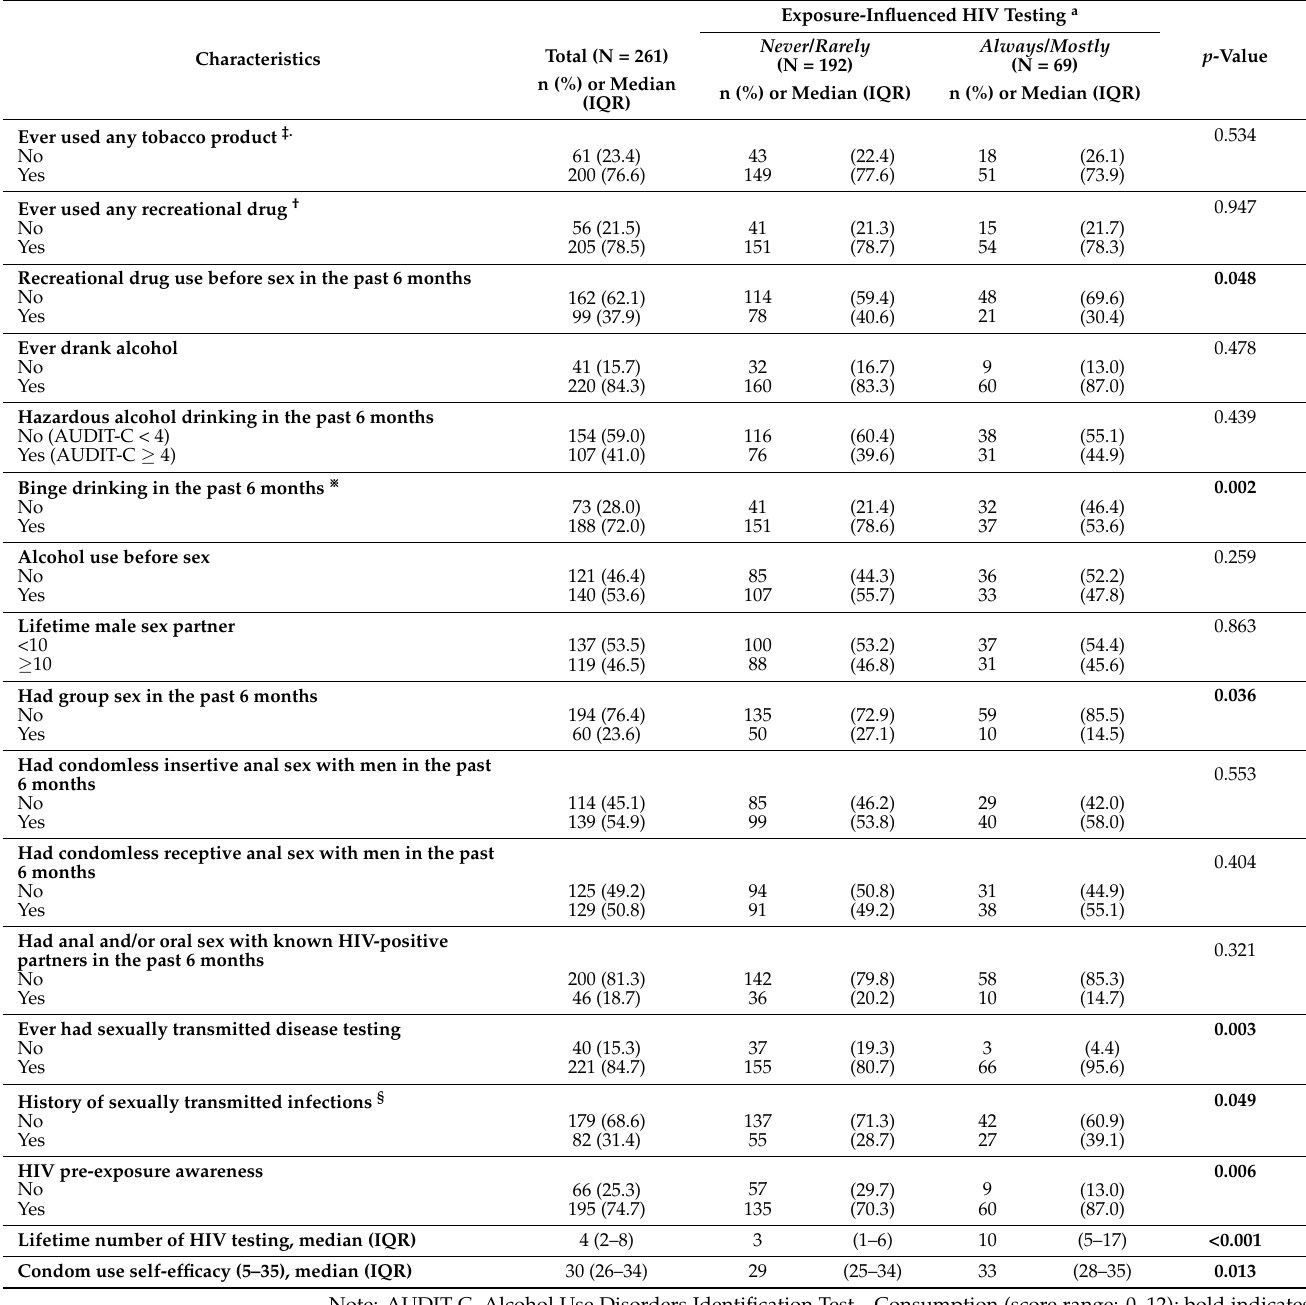
Table 2. Comparing the prevalence of substance use, sexual behaviors and HIV prevention indicators by exposure-influenced HIV testing among a sample of PrEP/PEP-naïve young men who have sex with men recruited from two US urban areas (N =